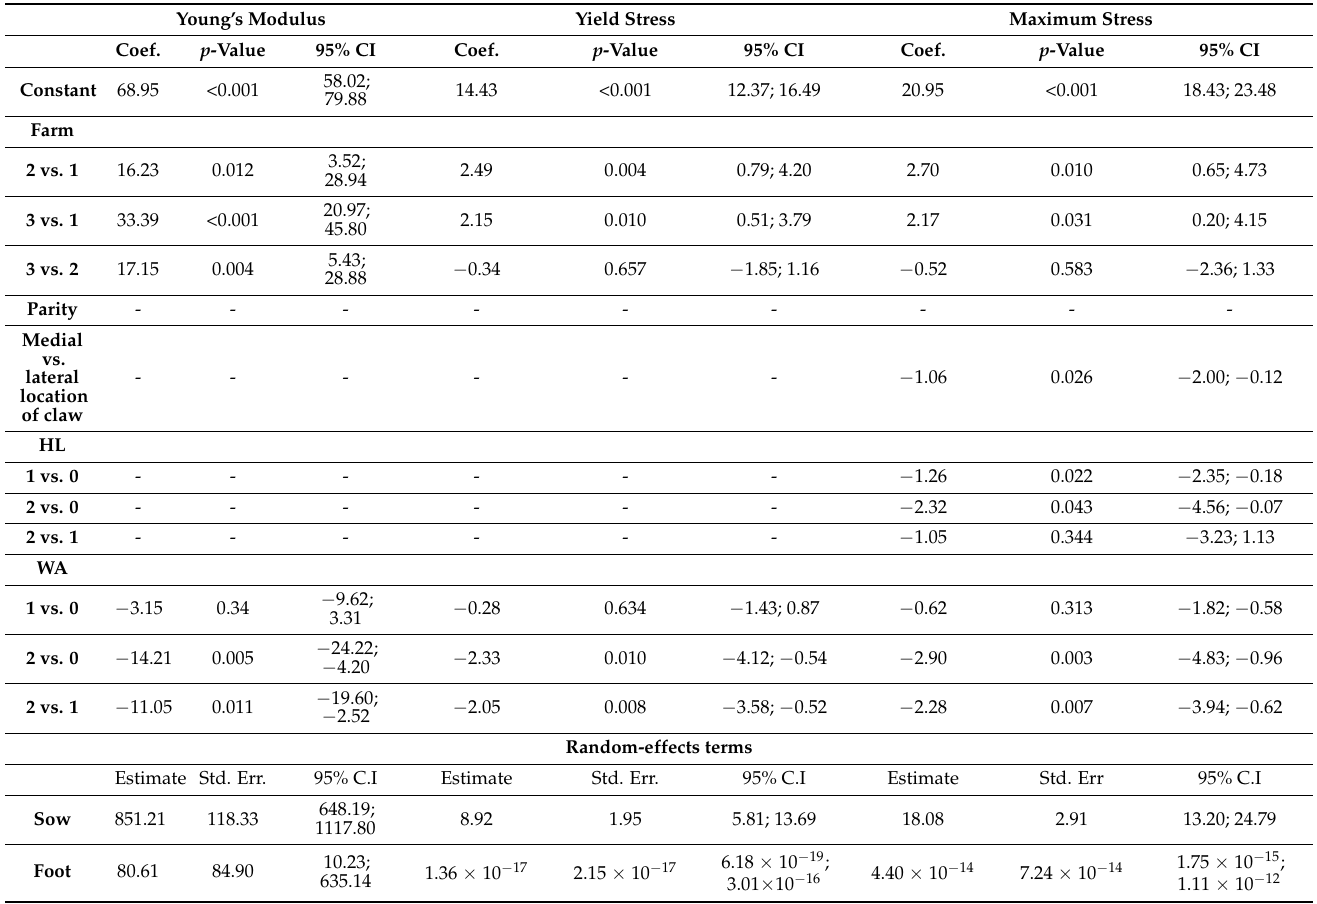
Table 5. The three final multivariable linear regression models for the association between each of the estimated mechanical indices of the hoof’s dorsal wall horn, the Young’s modulus, the yield stress, and the maximal stress, with scores of claw lesions on five anatomical sites of the claw, sow’s genetic line, sow’s parity and foot or claw location in 185 culled sows from three Greek herds. The anatomical sites of the claw examined and scored for lesions were the heel (HL), the sole (SL), the white line (WL), the wall (WA) and the coronary band (CB), with severity scores ranging from 0 to 2, except for the CB which ranged from 0 to 1. In addition to the fixed-effect terms, all the evaluated models included a random-effect term for sow and a random-effect term for foot nested within sow. Yield